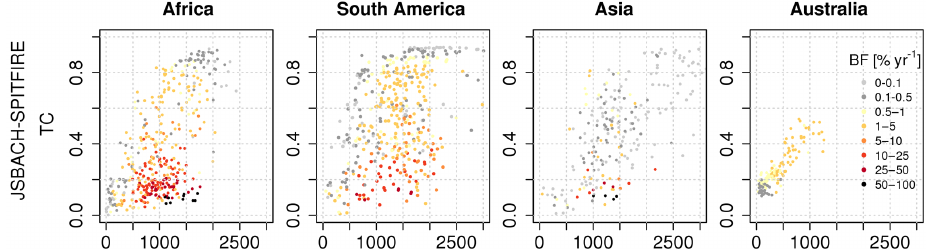
Figure A2. Modelled tree cover (TC) versus precipitation ( P ) (mmyear − 1 ). Modelled tree cover was filtered for vegetation height of trees < 5m using the modelled vegetation height. This value is given as the detection threshold for the satellite products. When filtering the model output with this threshold the differences to the unfiltered data set are very small (compare with Fig. 4 panels for JSBACH-SPITFIRE).